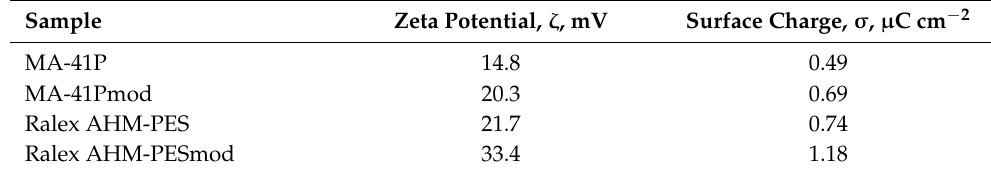
Table 2. Zeta potential and surface charge density values of studied